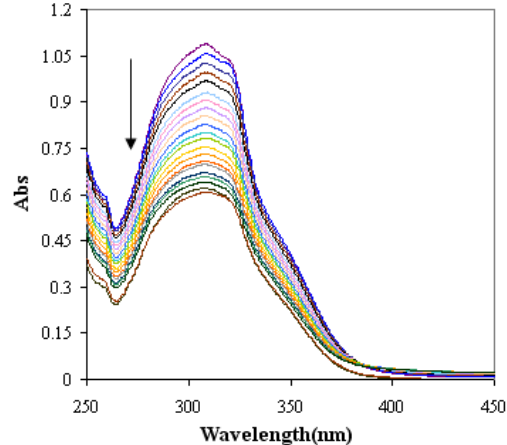
Fig. 1. Absorbance spectra of a 1×10 −5 mol l −1 solution of L in methanol, at different Hg 2+ concentrations. The arrow shows the direction of absorbance changes by increasing the metal ion concentration.